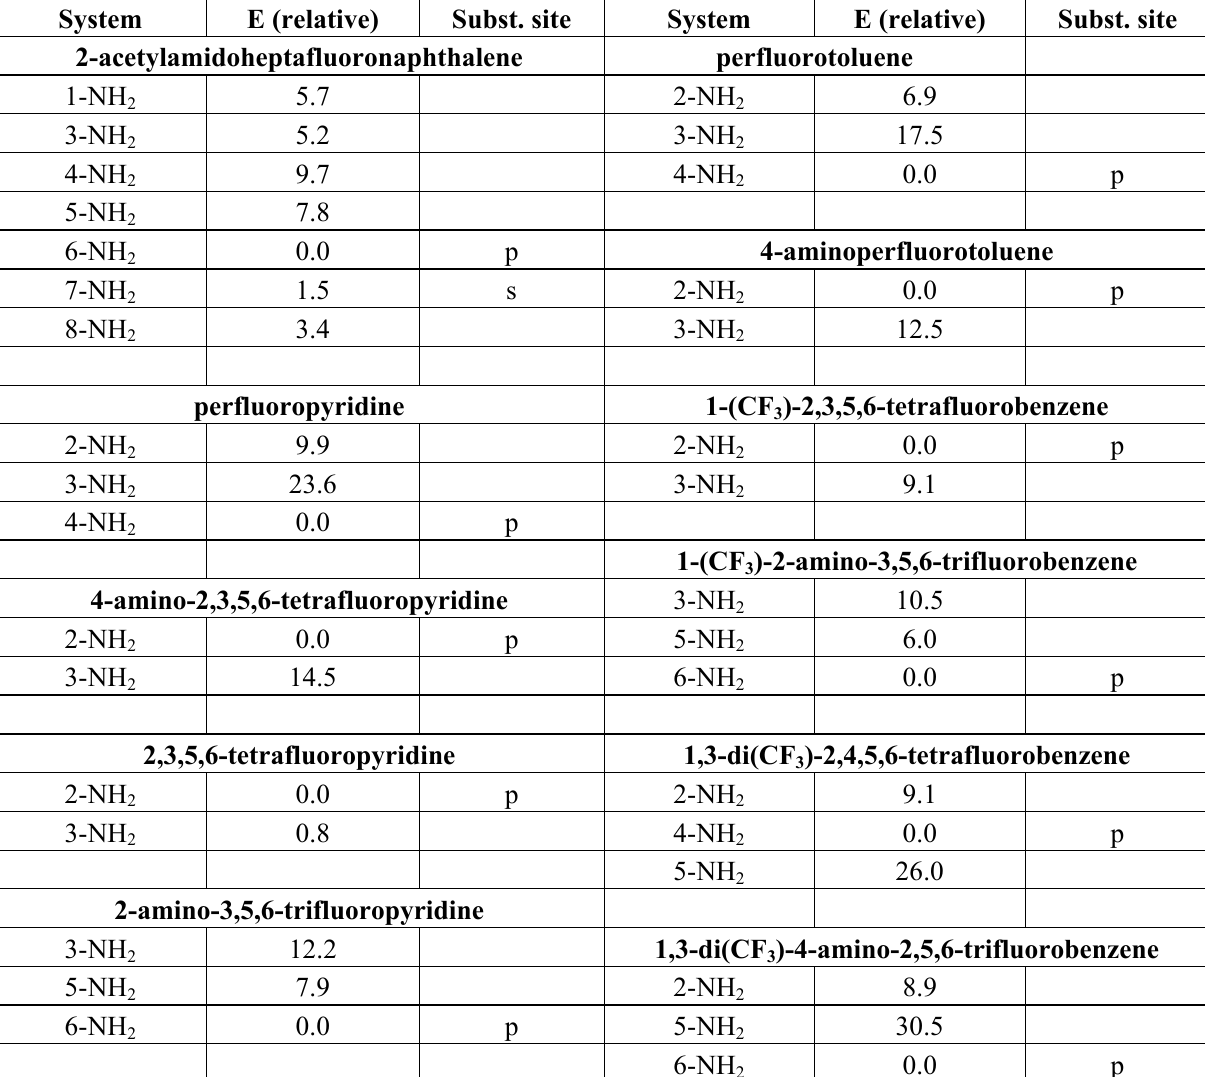
Table 2. Relative energies (kcal/mol) of the various Meisenheimer complexes for the amination reactions shown in Figure